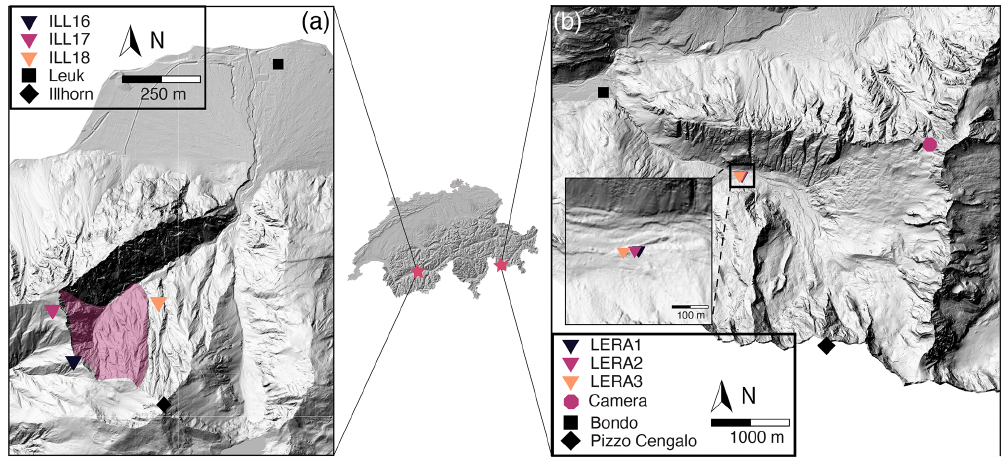
Figure 1. Illgraben catchment (a) and Val Bondasca (b) with locations in Switzerland (stars in middle panel). (a) Overview of the Illgraben catchment in Switzerland and locations of stations ILL16–18 depicted as colored triangles. (b) Overview of Val Bondasca. Location of LERA network depicted as colored triangles. Zoom-in shows individual seismic stations (LERA1–3) in the upper right corner. Digital elevation models ©